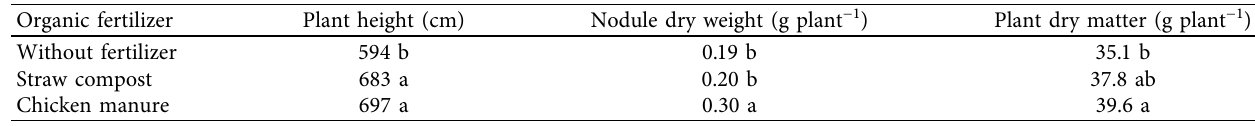
Table 3: Effect of organic fertilizer applied in the rainy season on nodule dry weight, plant dry matter, and plant height of soybean in the second dry season.